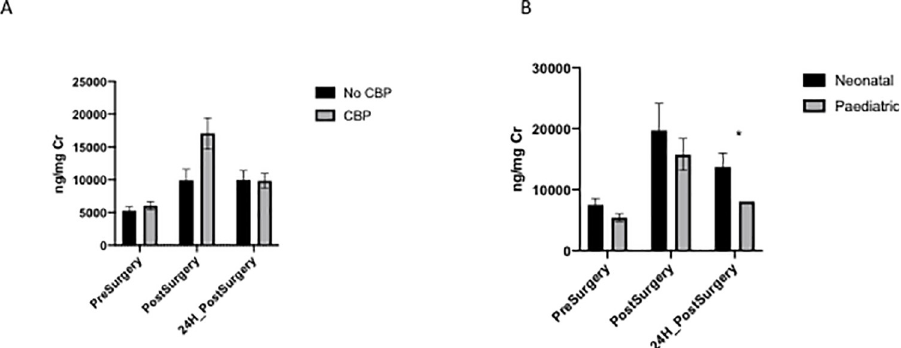
Fig 3. A: Isoprostane levels according to type of surgery. B : Isoprostanes levels only in CPB patients by age (Expressed in ng/mg Cr and Mean +/s SD). ( � p < 0.05).